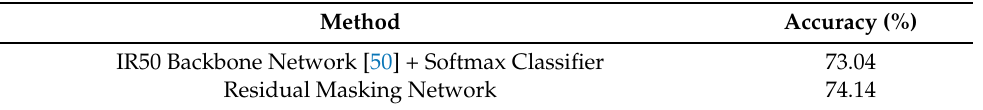
Table 4. Performance evaluation of different methods for facial emotion recognition on the FER2013